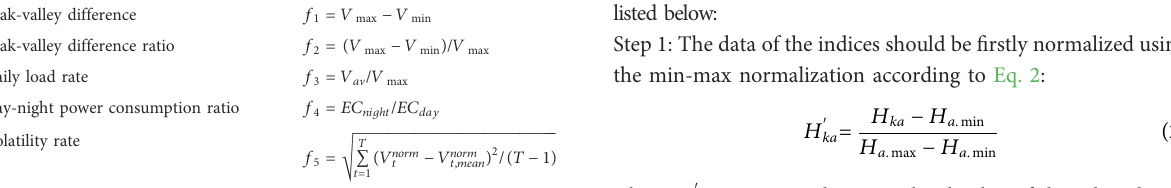
TABLE 1 The equations for delineating the power consumption volatility features. Index Expression Peak-valley